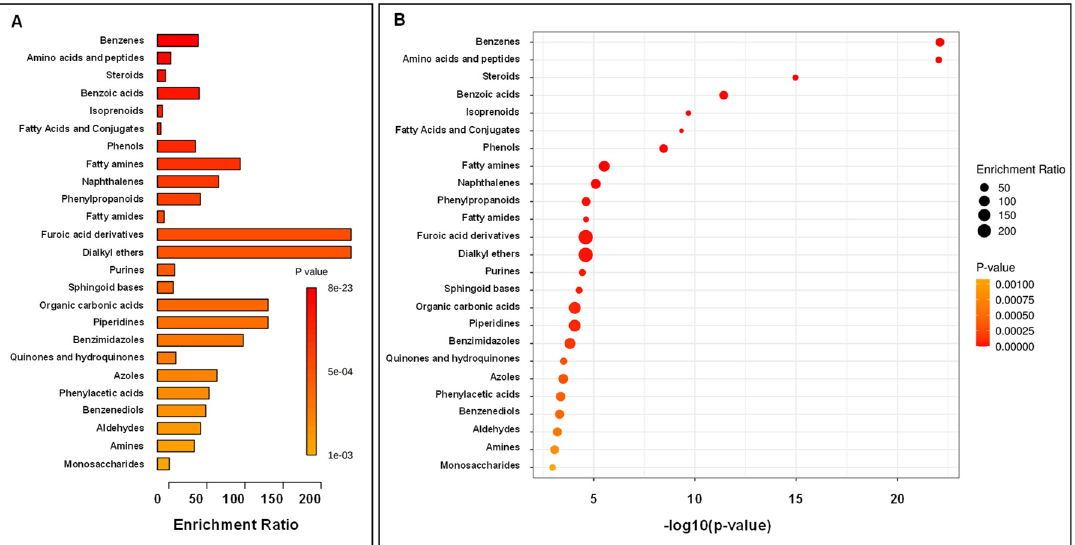
Figure 17. Summary of pathway enrichment analysis of soil samples based on main class compound analysis. The most significant p -values are in red, while the least significant are in orange. The Enrichment Ratio is computed by Hits/Expected, where hits = observed hits; expected = expected hits.